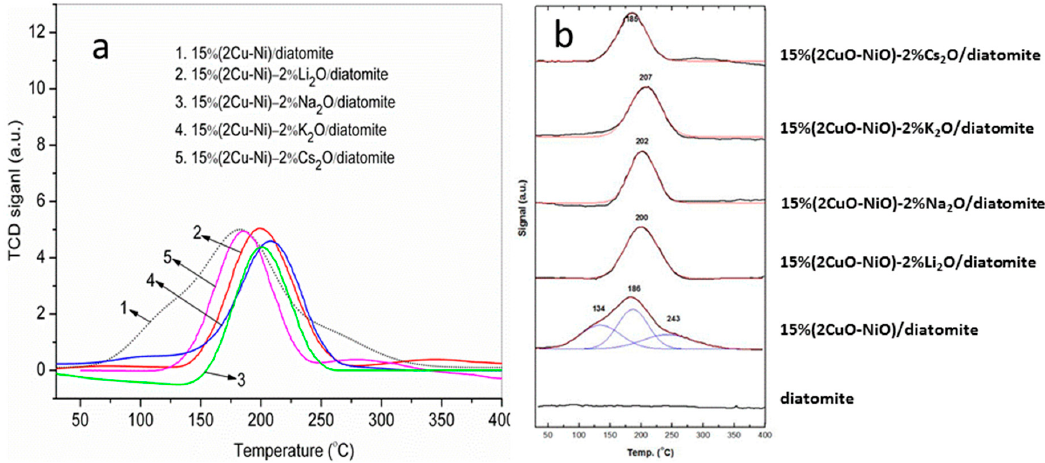
Figure 8. NH 3 Temperature-programmed desorption curves ( a ) and their fitting curves ( b ) of the samples.